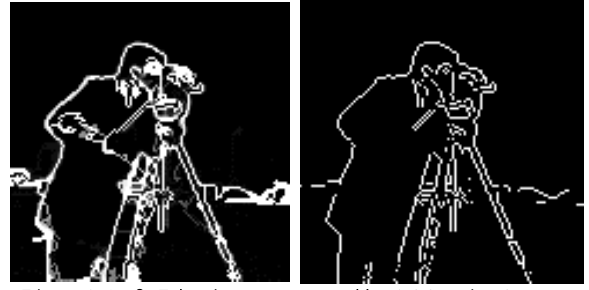
Figure 9. Left: Edge image computed by ACO using Canny magnitude and edge matrixes as initial pheromone and distribution matrixes. Right: Edge image computed using Canny operator.